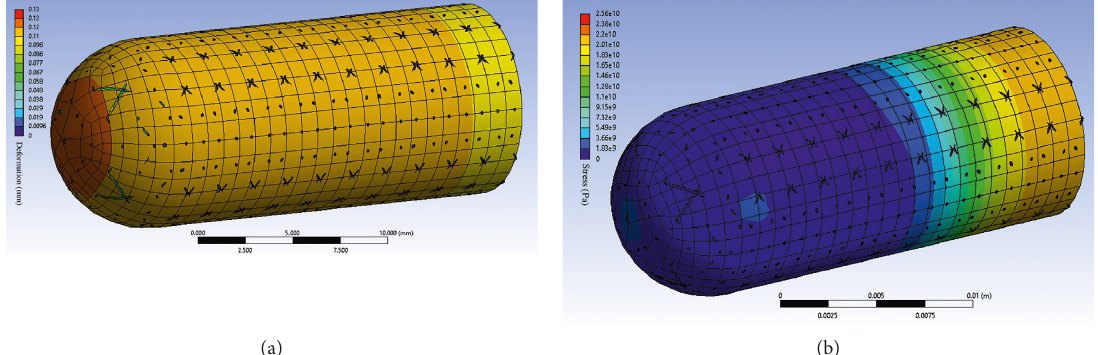
Figure 18: Deformation (a) and Von Mises stress distribution (b) of button made of solid diamond with Ti6Al4V lattice.